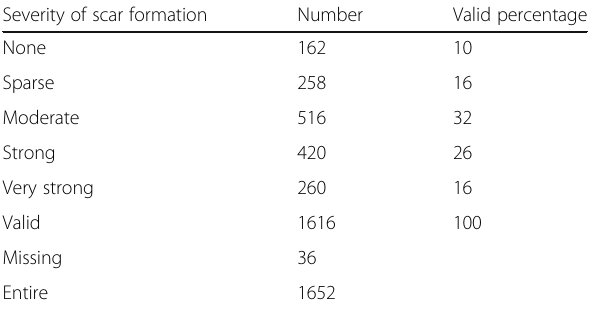
Table 3 Felt severity of scar formation by patients Severity of scar formation